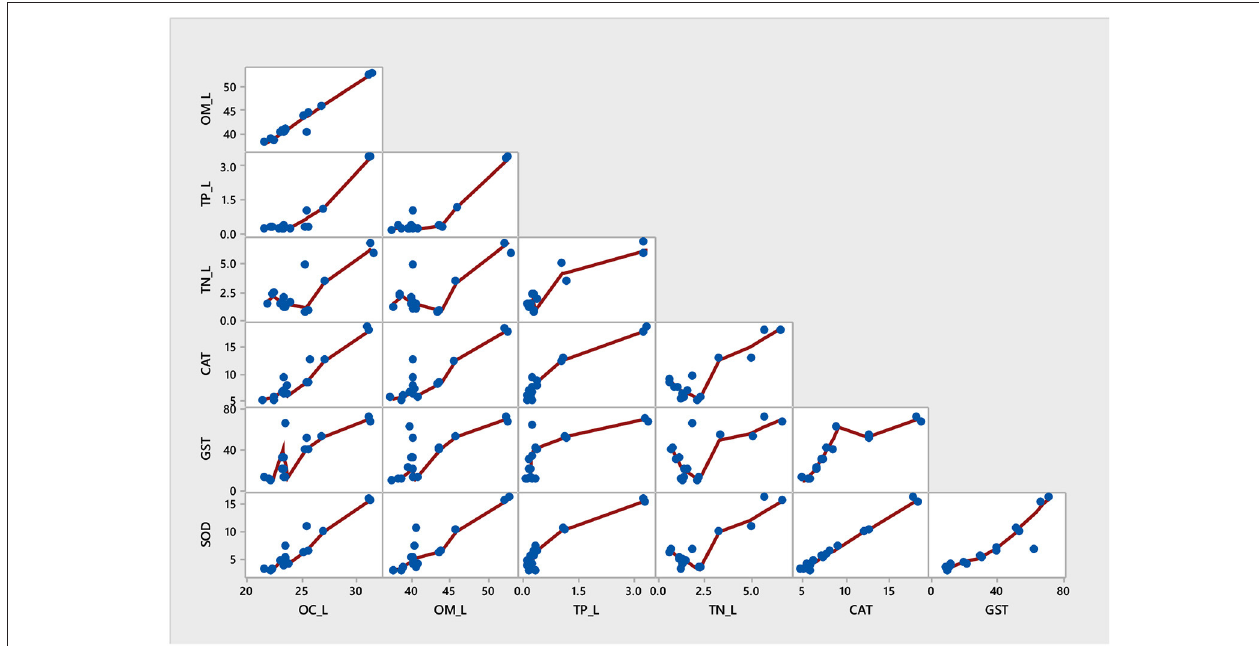
FIGURE 5 | Multivariate item analysis (MIA) for antioxidant enzymes activities and nutrients in mangrove A. marina .